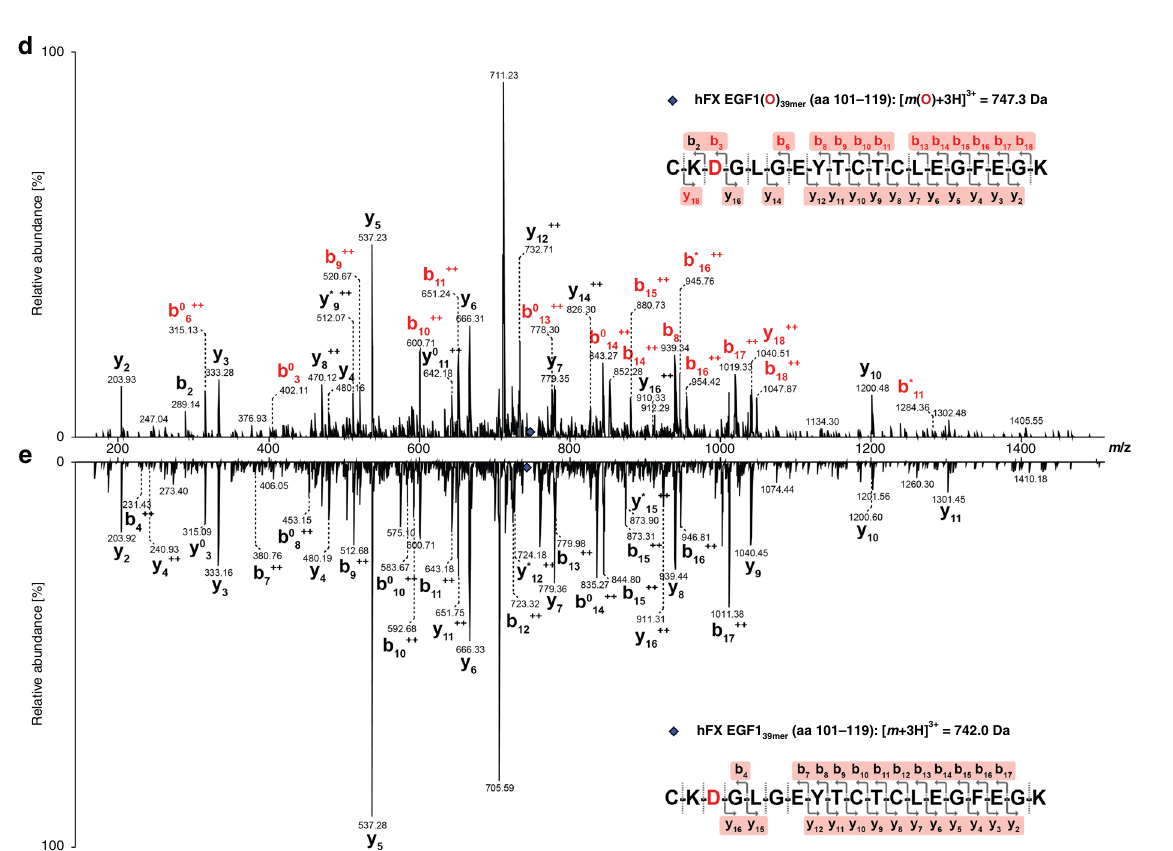
Fig. 1 EGF1 of human coagulation factor X undergoes AspH-catalysed hydroxylation at Asp103 hFX . MS/MS-analysis was performed using a Bruker Daltonics amaZon TM Ion Trap LC-MS/MS system equipped with a Dionex TM UltiMate ® 3000 HPLC machine. Endpoint turnover assays were performed under standard (non-redox) conditions (for details see Methods section). For MS/MS-analysis, after quenching, cystine disul fi des were reduced (dithiothreitol) and cysteine thiols derivatized with iodoacetamide. a Reaction scheme for diastereospeci fi c AspH-catalysed hydroxylation of Asp/Asn- residues in EGFDs. b Schematic structure and calculated mass of the expected disul fi de isomer of hFX EGF1 39mer (aa 86 – 124) featuring a canonical disul fi de connectivity pattern (Cys1 – 3, 2 – 4, 5 – 6; green); the hydroxylation site (Asp103 hFX ) is in red. c His 6 -AspH 315 – 758 catalysed hydroxylation of hFX EGF1 39mer proceeds with ~40% conversion under standard (non-redox) conditions; the light orange graph represents a control in which AspH was replaced by buffer. d LC-MS/MS analysis of the relevant digestion fragment of hFX EGF1 39mer (aa 101 – 119), which is partially hydroxylated (~40%) after treatment with His 6 - AspH 315 – 758 , con fi rms AspH-catalysed hydroxylation takes place at Asp103 hFX as anticipated based on the AspH-substrate consensus sequence (fragments bearing β -hydroxy-Asp are in red). e LC-MS/MS analysis of the relevant digestion fragment of hFX EGF1 39mer (aa 101 – 119) before exposure to His 6 -AspH 315 – indicates that the R735W substitution, present in a Traboulsi syndrome patient 8 , likely interferes with 2OG binding.